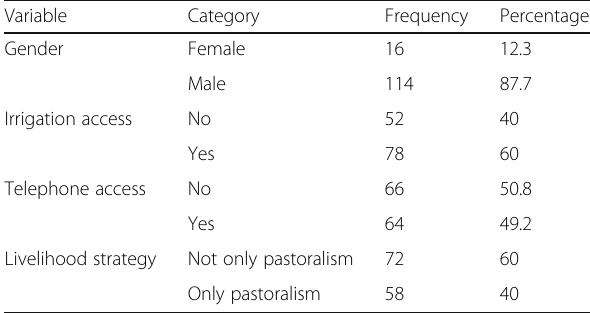
Table 1 Descriptive statistics results (dummy variables)